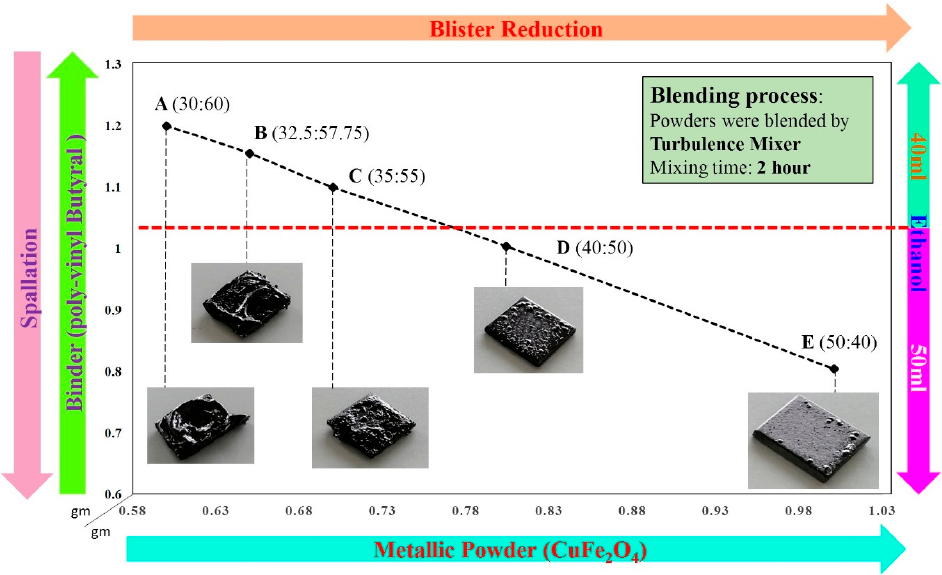
Figure 2. Coated sample from different slurry ratios.